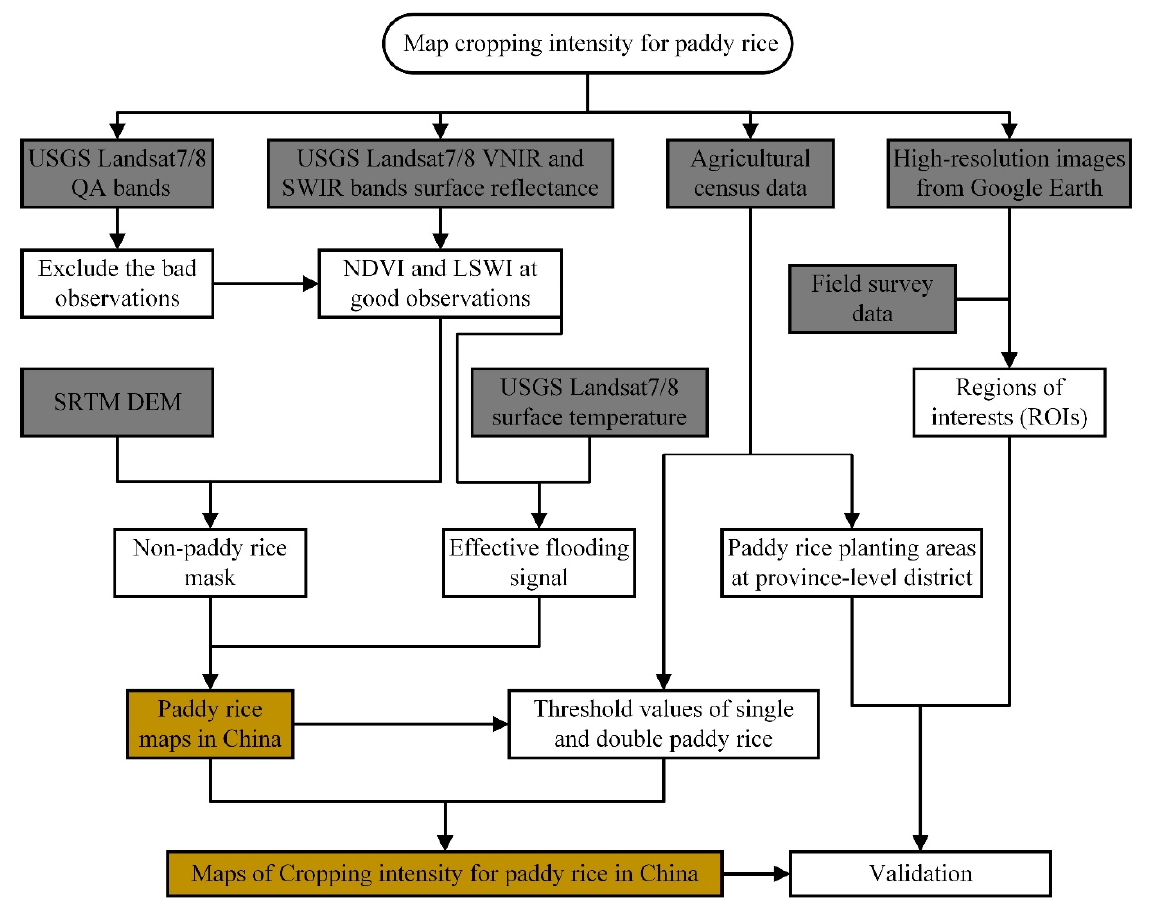
Figure 4. The workflow for Landsat-based and the effective flooding signal-based phenology (EFSP) method to map cropping intensity for paddy rice (CIPR) in China. Four modules comprise the method, namely, Landsat image preprocessing, effective flood signal calculation, threshold value determination for single and double paddy rice, and validation based on agricultural census data, field survey, and high-resolution images.